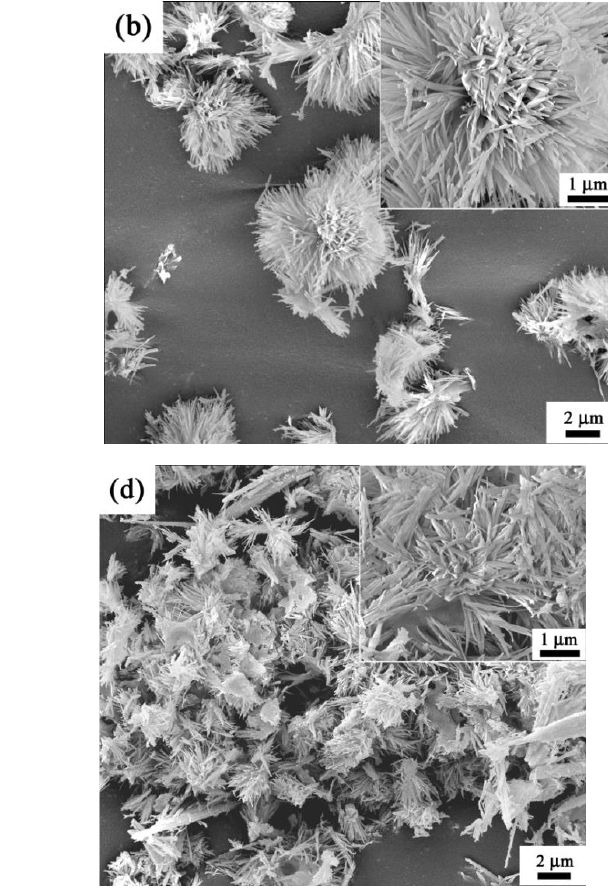
3 of 9 Figure 1. X-ray diffraction (XRD) patterns of deposited precursors fabricated by hydrothermal method under different molar ratio of Al 3+ :CO(NH 2 ) 2 : ( a ) 1:3, ( b ) 1:5, ( c ) 1:6 and ( d ) 1:7. In order to clearly understand the morphology change of whiskers with different urea content, scanning electron microscope (SEM) was adopted to observe the deposited powders, as shown in Figure 2. It is seen that when the molar ratio of Al 3+ :CO(NH 2 ) 2 is selected as 1:3, most of obtained precursors are balls covered by oriented whiskers (Figure 2a). The mean size of balls is measured as 7.8 μm. By increasing the content of urea, all balls disappear when the molar ratios of Al 3+ :CO(NH 2 ) 2 are 1:5 and 1:6 and all formed precursors are agglomerated oriented whiskers like chrysanthemum (Figure 2b,c). The length of both whiskers is about 1.5 μm and the mean widths of whiskers are 0.1 and 0.15 μm respectively. Based on the XRD spectra in Figure 1, it is concluded that the balls are NH 4 Al 3 (SO 4 ) 2 (OH) 6 phase and the whiskers are AlO(OH) phase. Under the higher urea loading with the molar ratio of Al 3+ :CO(NH 2 ) 2 of 1:7, most of the whiskers disperse like